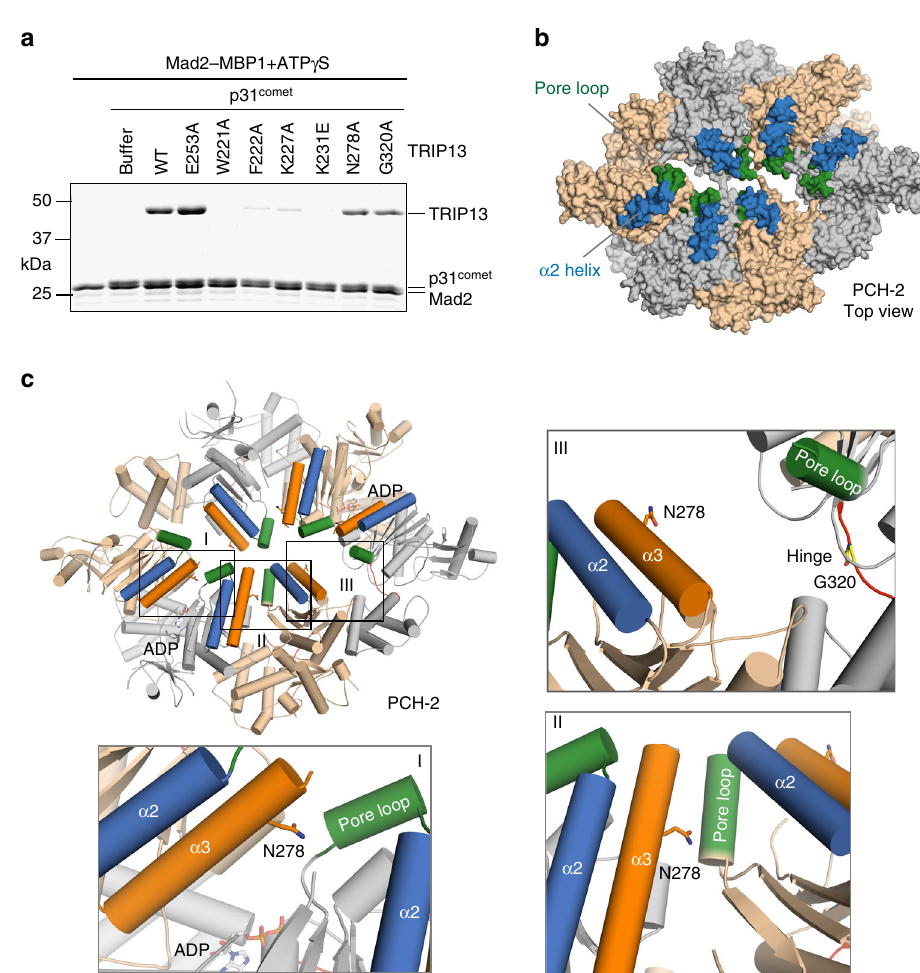
Fig. 6 Identi fi cation of a p31 comet – Mad2-binding site on TRIP13. a MBP1-coupled beads were fi rst incubated with Mad2, and then incubated with TRIP13 wild type (WT) or the indicated mutants (500 nM), Δ N35-p31 comet (1 µ M), and ATP γ S (1 mM). Proteins bound to beads were analyzed by SDS-PAGE and stained with Coomassie blue. b Surface diagram of C. elegans PCH-2 in the top view, with the pore loop and α 2 helix colored green and blue, respectively. c Cartoon diagram of C. elegans PCH-2, with zoomed-in views of the boxed interfaces (I – III) shown. N278, ADP, and G320 are shown in sticks. The pore loop, the α 2 helix, and the α 3 helix are colored green, blue, and orange, respectively. Each of the three types of interfaces is present twice in the PCH-2